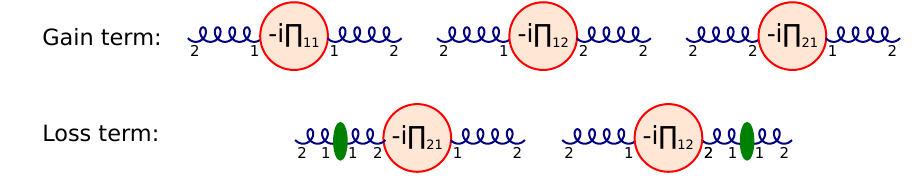
Figure 4 . Grouping the diagrams for rescattering. Here, the green ovals represent the diagrams at O ( A 2 3 g 6 ) while the circles denote 2PI